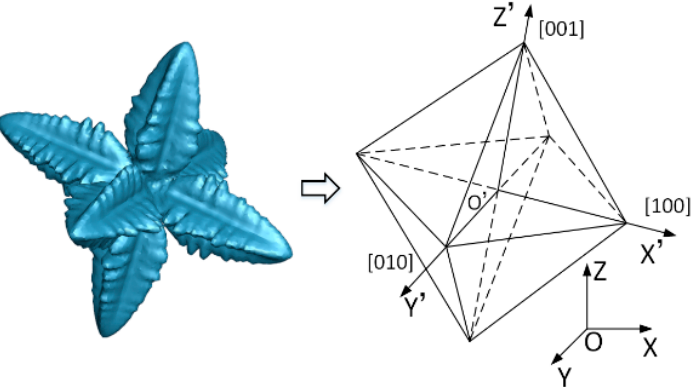
Figure 1. Octahedral grain envelope.